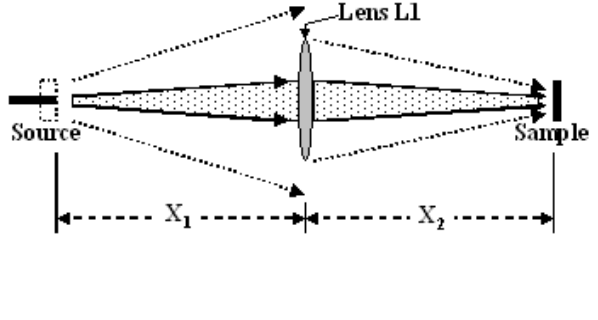
Figure 2. Schematic of a larger source like an LED (dotted box) or a small source such as a laser (black line), and a lens that collects the light and focuses it on the